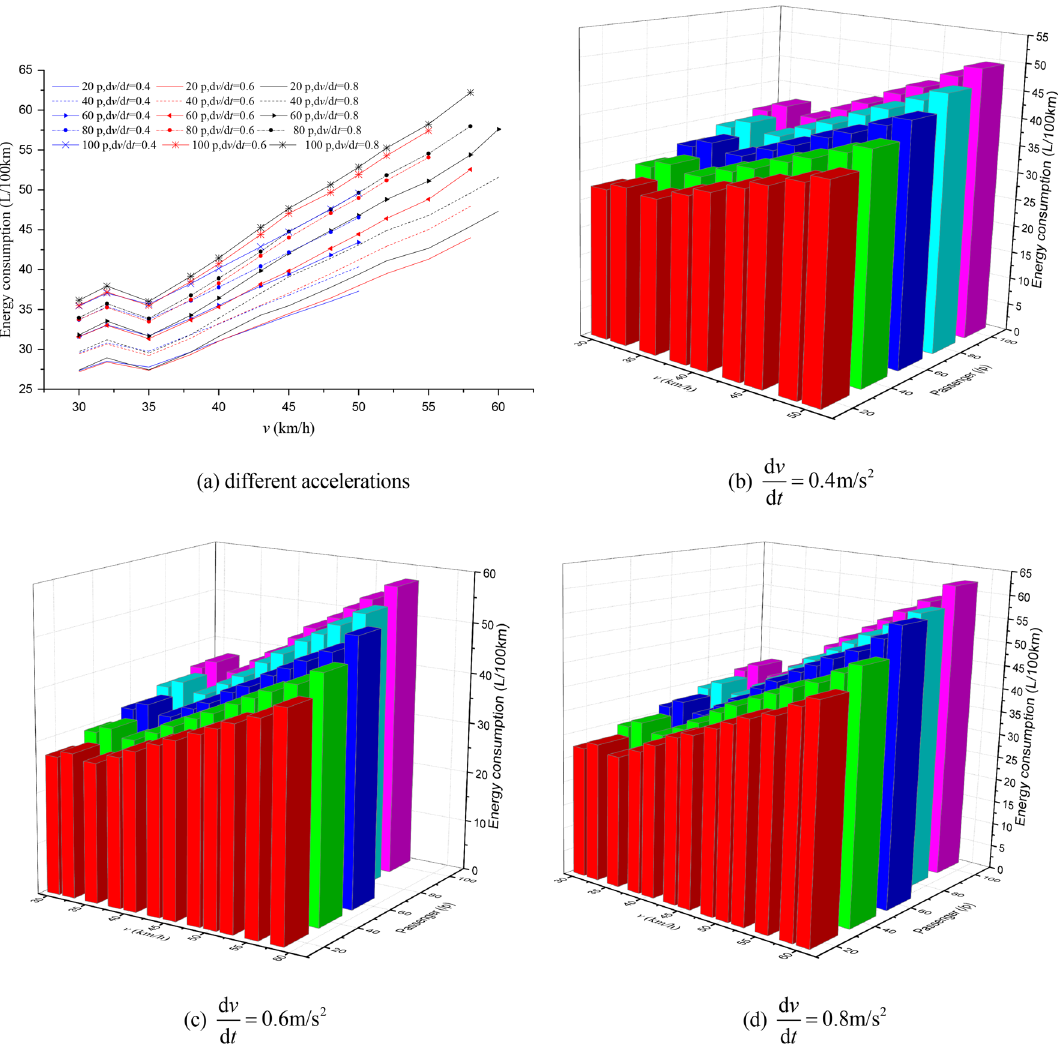
Figure 7. The EC of different passenger load, acceleration and maximum speed for 400 m station